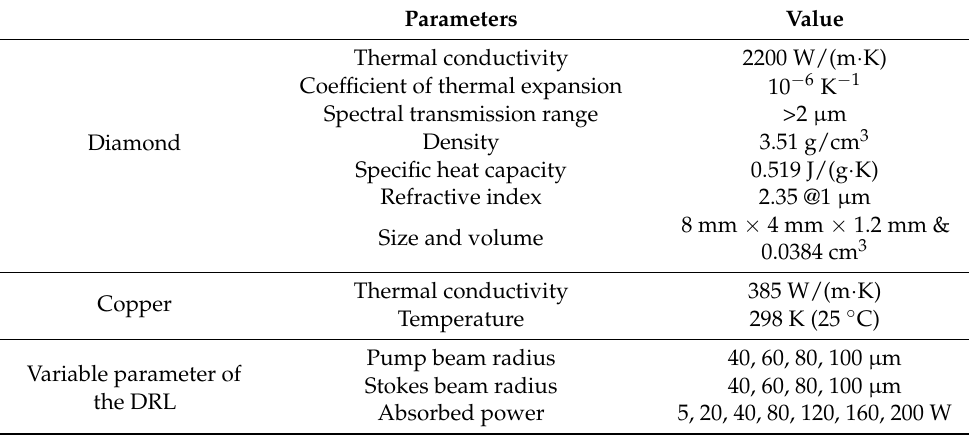
Table 1. Parameters of the diamond and setup for